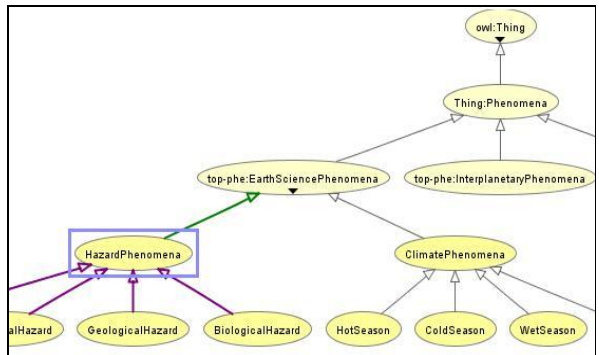
Figure 6. The hierarchical structure of subsumption relation among concepts in